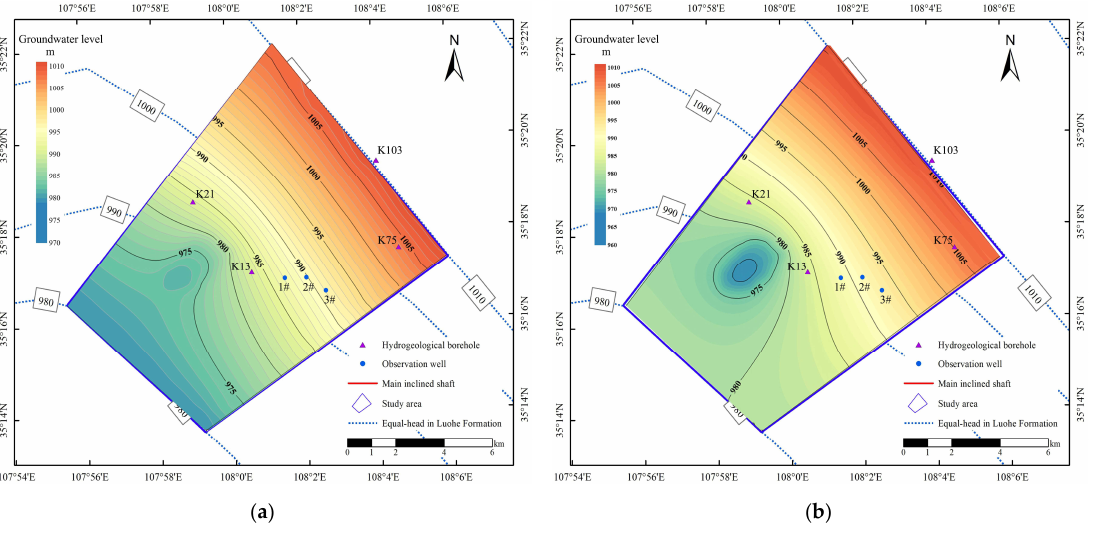
Figure 12. The groundwater level contour map under the groundwater drainage rate was 806.83 m 3 /h: ( a ) the Huanhe Formation aquifers; ( b ) the Luohe Formation aquifer.